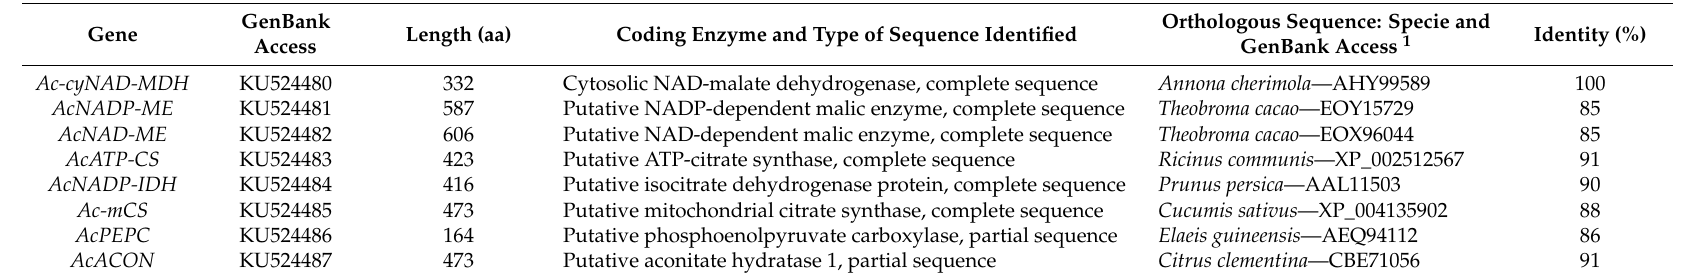
Table 2. Isolated genes related to organic acid metabolism in Annona cherimola